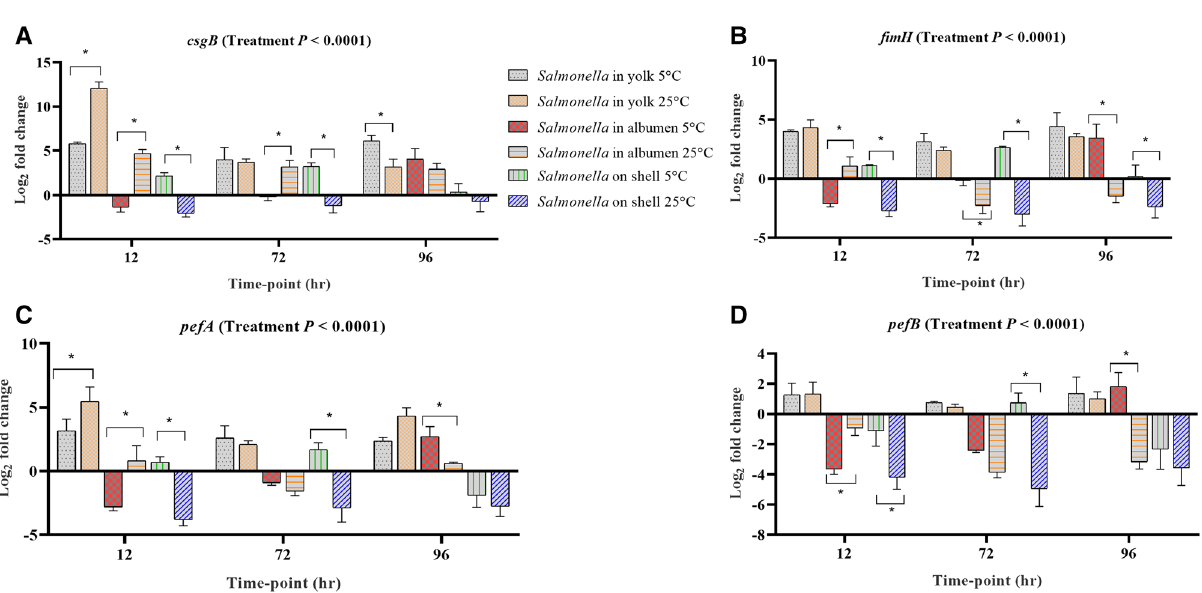
Figure 5. Regulation of genes at different storage time-points of Salmonella inoculated yolk, albumen and egg surface stored at 5 °C and 25 °C. Relative expression (log 2 fold change ± S.E.) of ( A ) csgB ; ( B ) fimH ; ( C ) pefA and ( D ) pefB . Within each egg component and storage time-point, asterisks across the bars show significant differences (P <